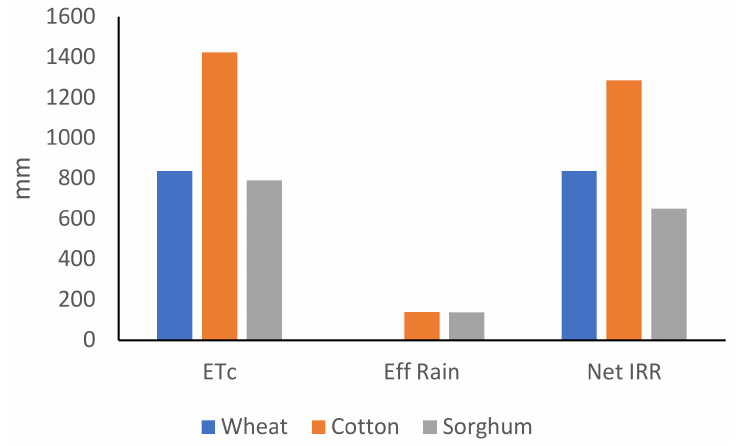
Figure 12. Comparison of ET c (crop evapotranspiration), effective rain (Eff. Rain), and net irrigation (Net IRR.) values for selected crops at site 5.